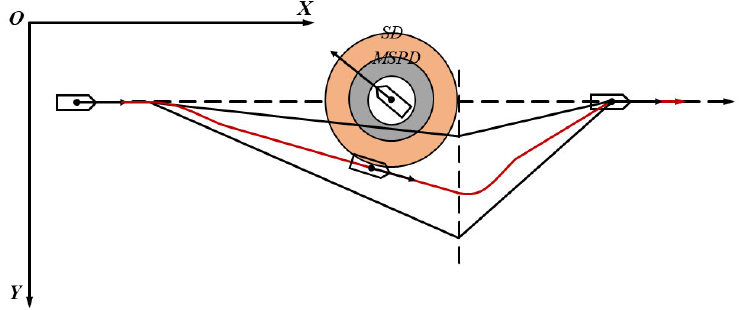
Figure 2. Illustration of the collision avoidance process of a ship at the manual operation level. The red line represents the collision avoidance path decided by the OOW, while the area between the two black lines shows the distribution range of the positions of ships.